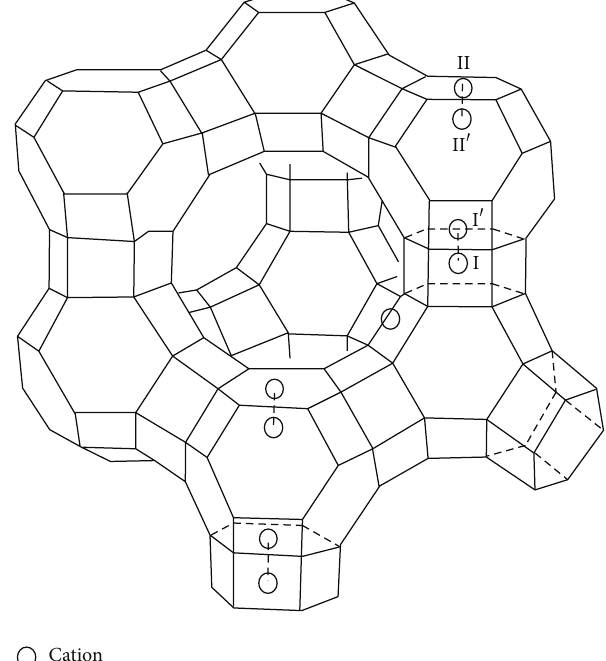
Table 1: Distribution of cations over sites [14].